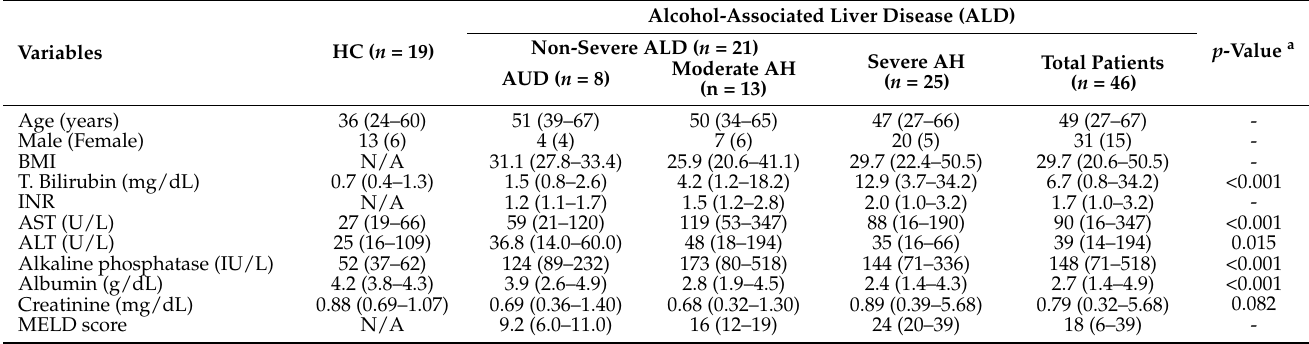
Table 1. Demographic, and liver indicators of study participants by